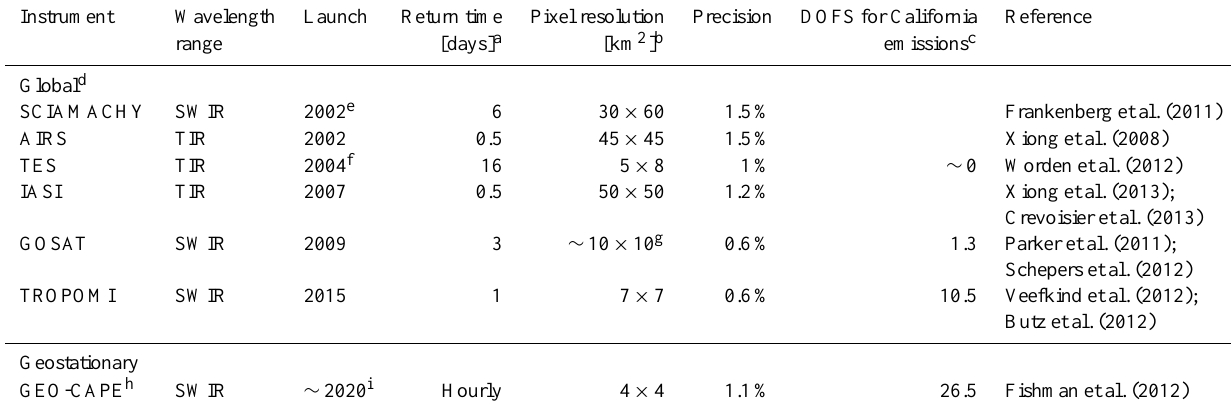
Table 1. Satellite observations of